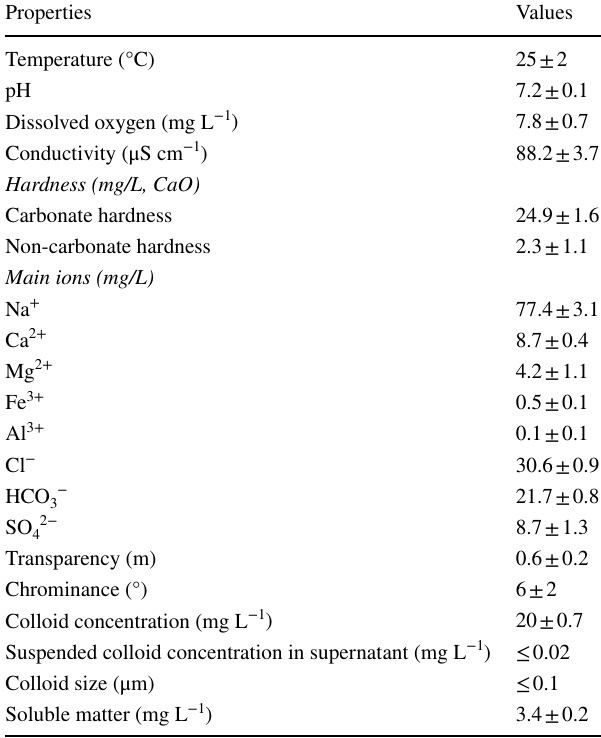
Table 1 Properties of the experimental waters